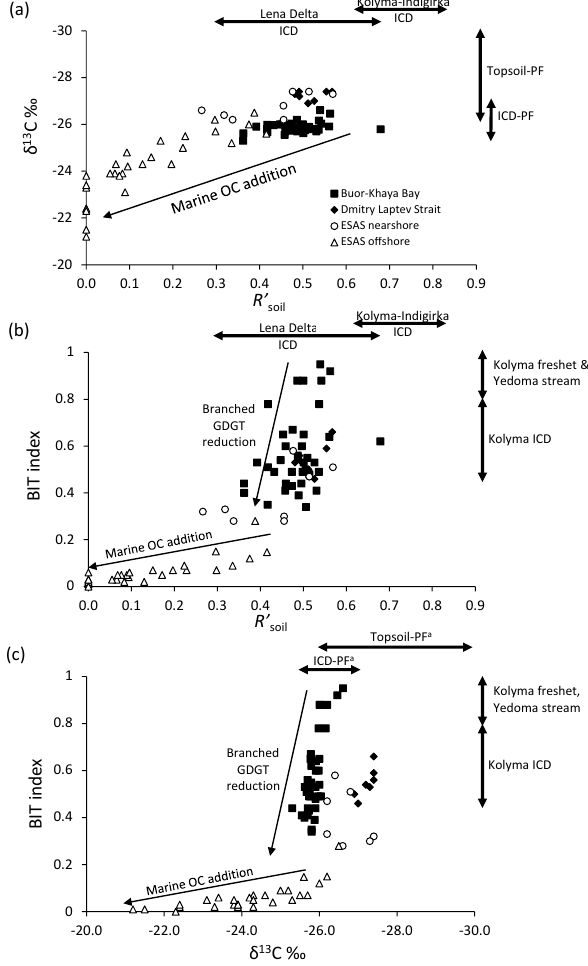
Figure 5. Cross plots of R (cid:48) soil vs. (a) bulk δ 13 C (Karlsson et al., 2011) and (b) BIT index (Sparkes et al., 2015) and (c) BIT index vs. δ 13 C in ESAS sediments. Typical values for terrestrial BIT in- dex vs. δ 13 C endmembers are indicated ( R (cid:48) soil – this study; δ 13 C – Vonk et al., 2012; BIT index – Bischoff, 2013 and Peterse et al., 2014). Note BHP and bulk carbon isotope plot shows linear mix- ing trend, whilst BIT index shows non-linear relationship to both other parameters; the BIT index drops significantly before a shift in isotope ratio to more marine values or shift to lower R (cid:48) soil values. R (cid:48) soil endmember values are lower than 1 due to presence of BHT in terrestrial materials (Table S3) and typically lower in the Lena River region (mean = 0.50) than in the eastern ESAS region (mean = 0.76). a ICD, ice complex deposit; PF, permafrost.